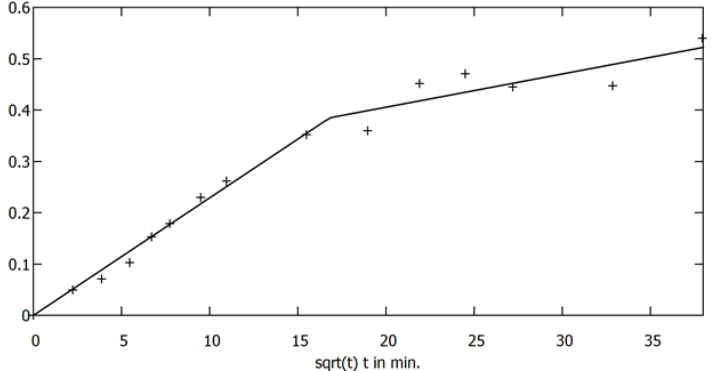
Figure 8. The dependence on the amount of mercury accumulated on the sorbent as a function of the square root of time.